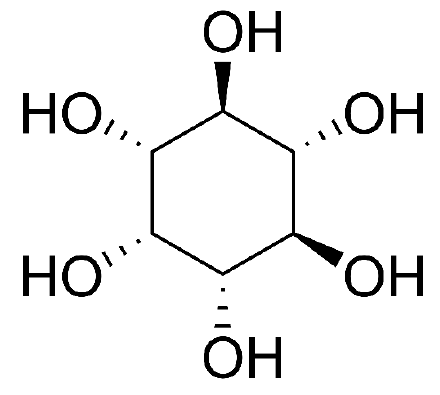
Figure 5. Structural formula of myo -inositol.